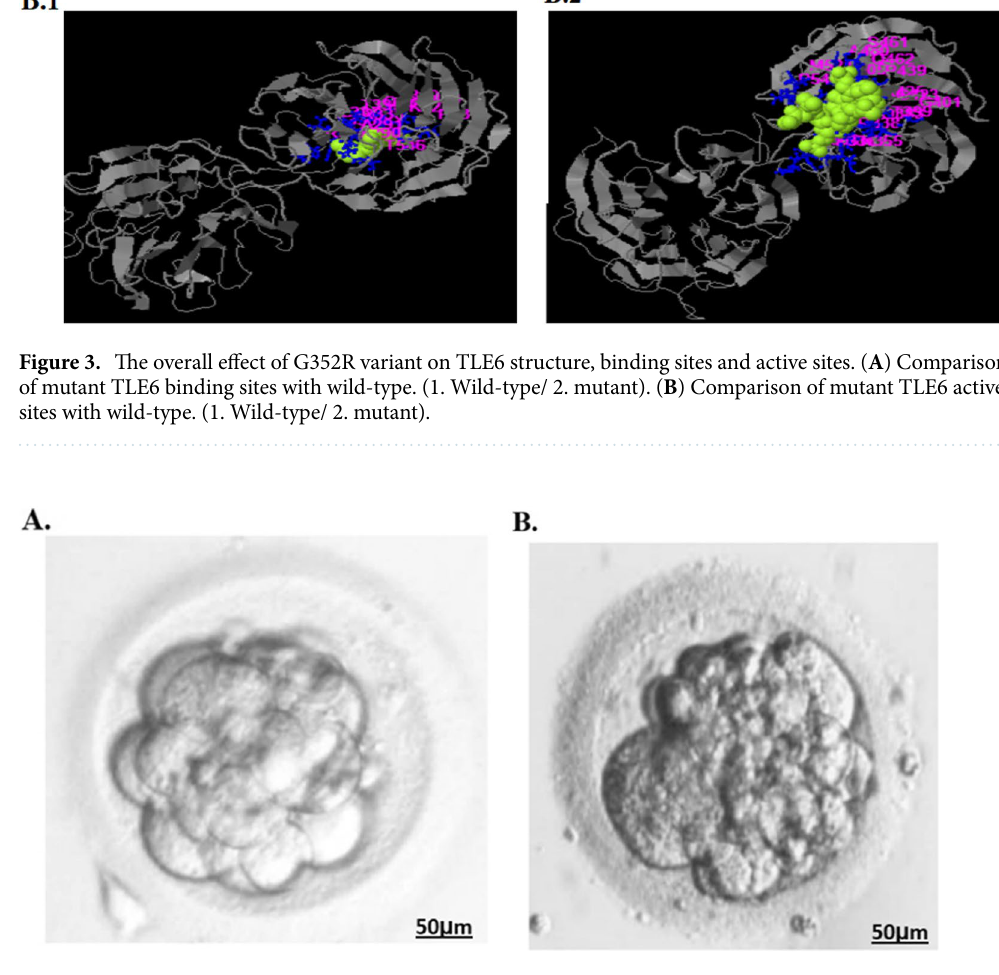
Figure 4. Phenotype of embryo from the proband